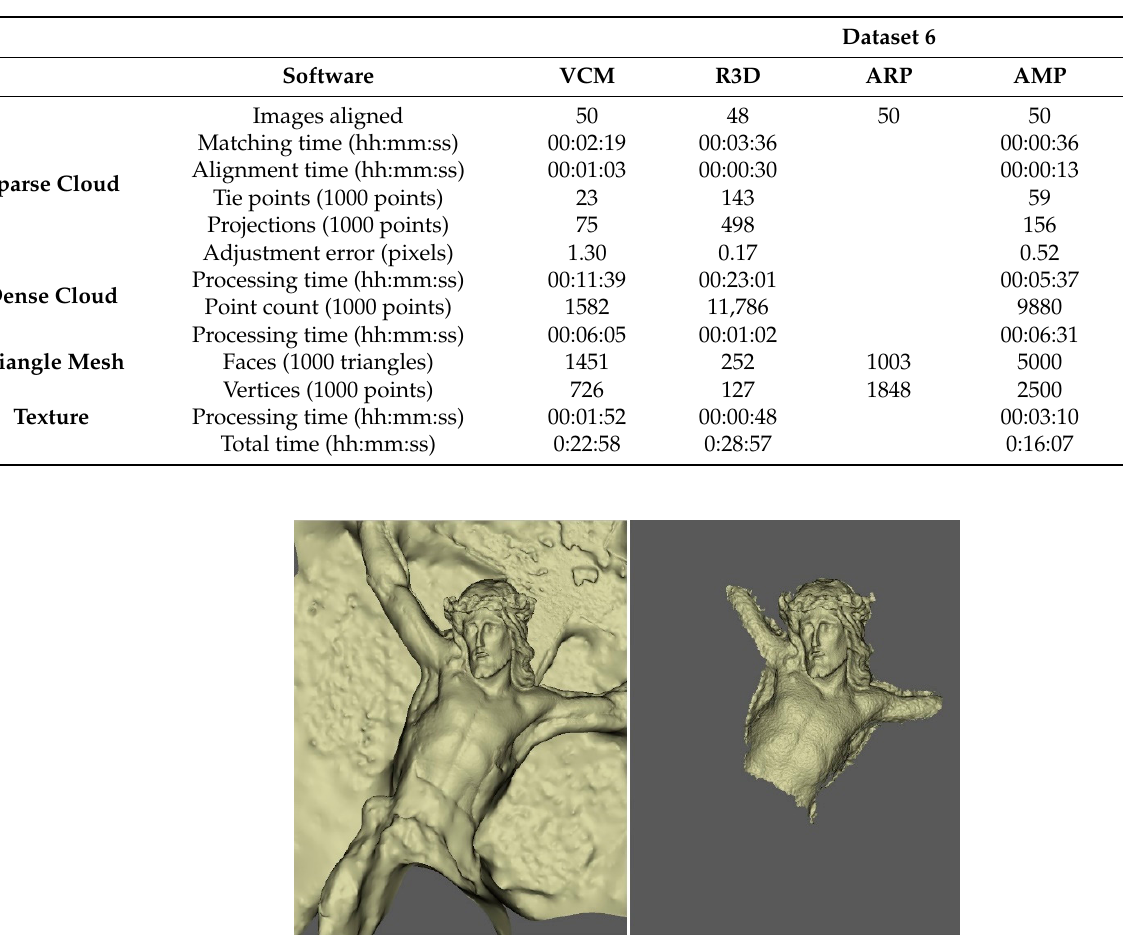
Table 6. Photogrammetric results, dataset 6.